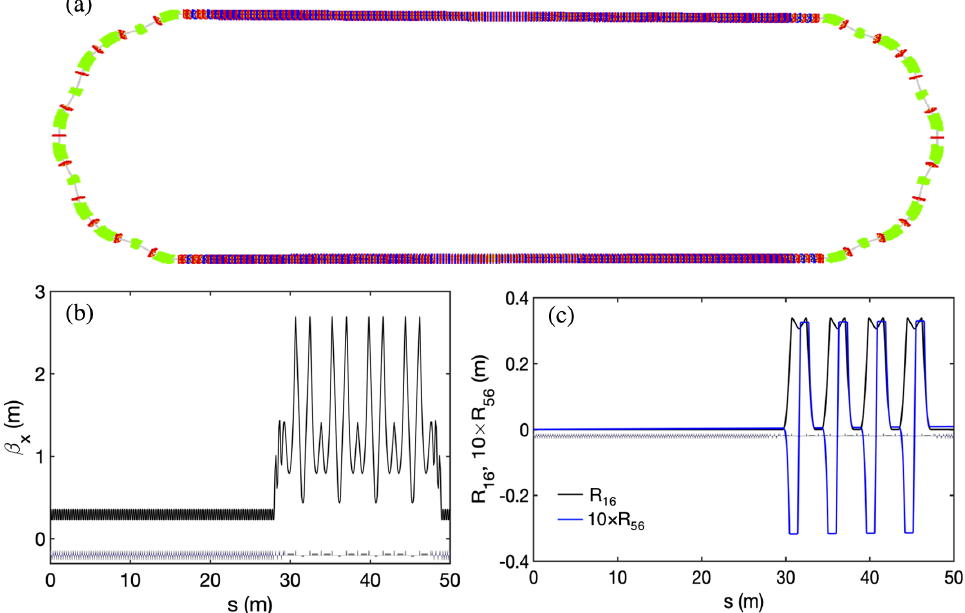
FIG. 4. (a) Schematic layout of the recirculating IBS ring, where dipoles are marked as green, focusing quadrupoles as red, and defocusing quadrupoles as blue. (b) Courant-Snyder envelope function. (c) Dispersion R 16 and momentum compaction R